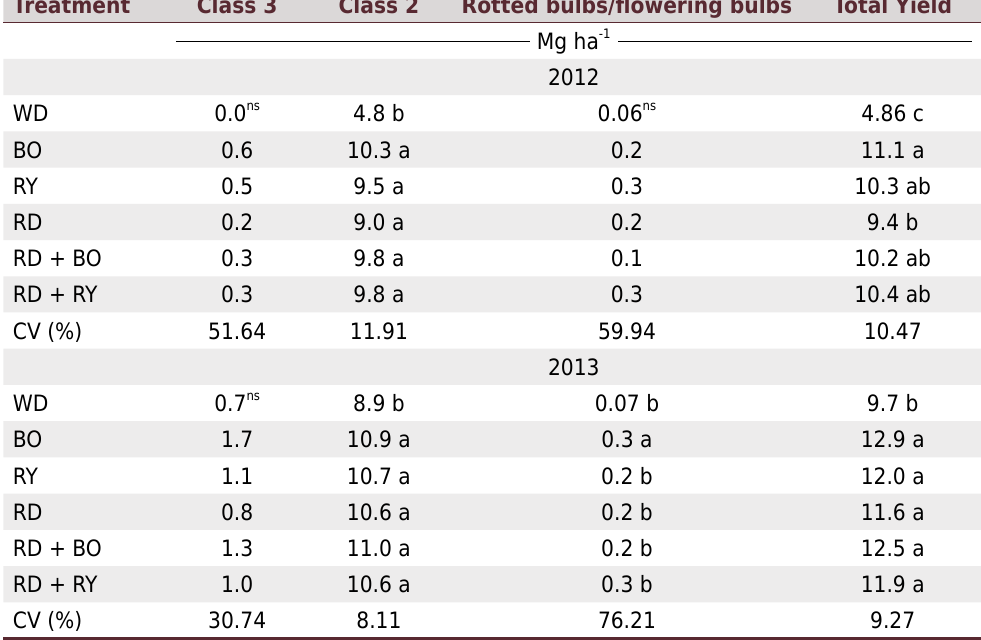
Table 4. Onion bulb yield for commercial classes 2 and 3, rotted bulbs/flowering bulbs, and total yield in the 2012 and 2013 crop seasons under the management practice of cover crops with residues of weeds (WD), black oat (BO), rye (RY), oilseed radish (RD), oilseed radish + black oat (RD + BO), and oilseed radish + rye (RD + RY) deposited on the onion row